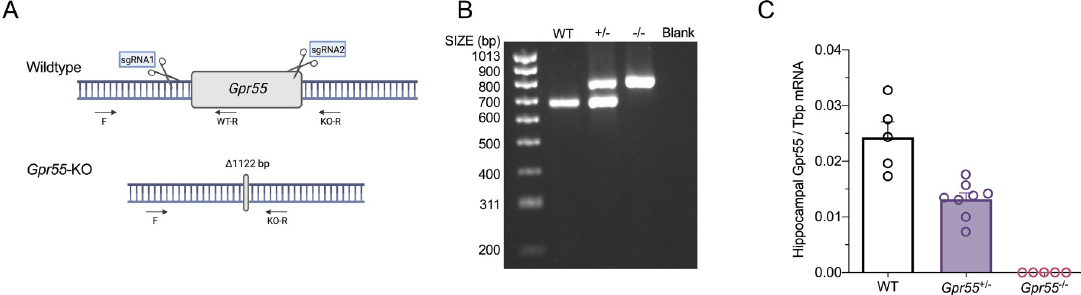
Fig 2. Generation and molecular characterization of Gpr55 +/- mice. ( A ) Schematic of the CRISPR/Cas9 strategy to delete Gpr55 . The binding sites of the CRISPR/Cas9 guide RNAs are noted as sgRNA1 and sgRNA2. The arrows show binding sites of the genotyping primers. Schematic created using BioRender.com. ( B ) DNA genotyping gel showing wildtype (WT), Gpr55 +/- (+/-) and Gpr55 -/- progeny (-/-) with a no DNA control (Blank). ( C ) Relative Gpr55 transcript levels in the hippocampus of wildtype, Gpr55 +/- and Gpr55 -/- mice, revealing a complete loss of Gpr55 expression in homozygous knockouts. Gpr55 expression was measured in primary RNA pools using RT-ddPCR and expressed as a ratio of Tbp . Data represents mean ± SEM, with n = 5–8 per group (WT: 3 males, 2 females; Gpr55 +/- : 4 males, 4 females; Gpr55 -/- : 2 males, 3